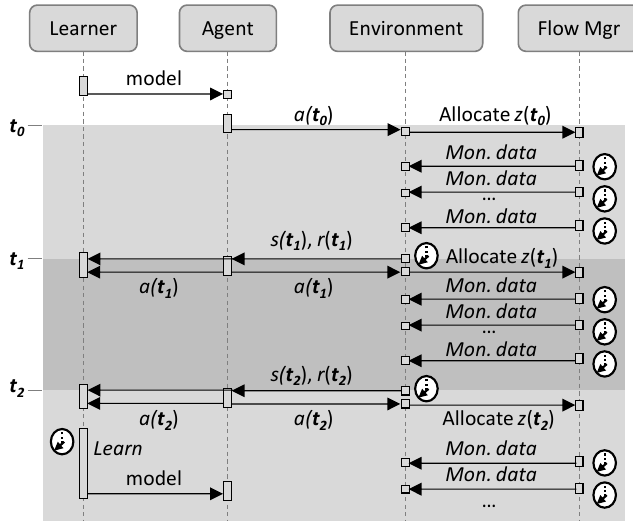
Figure 6. General RL workflow.